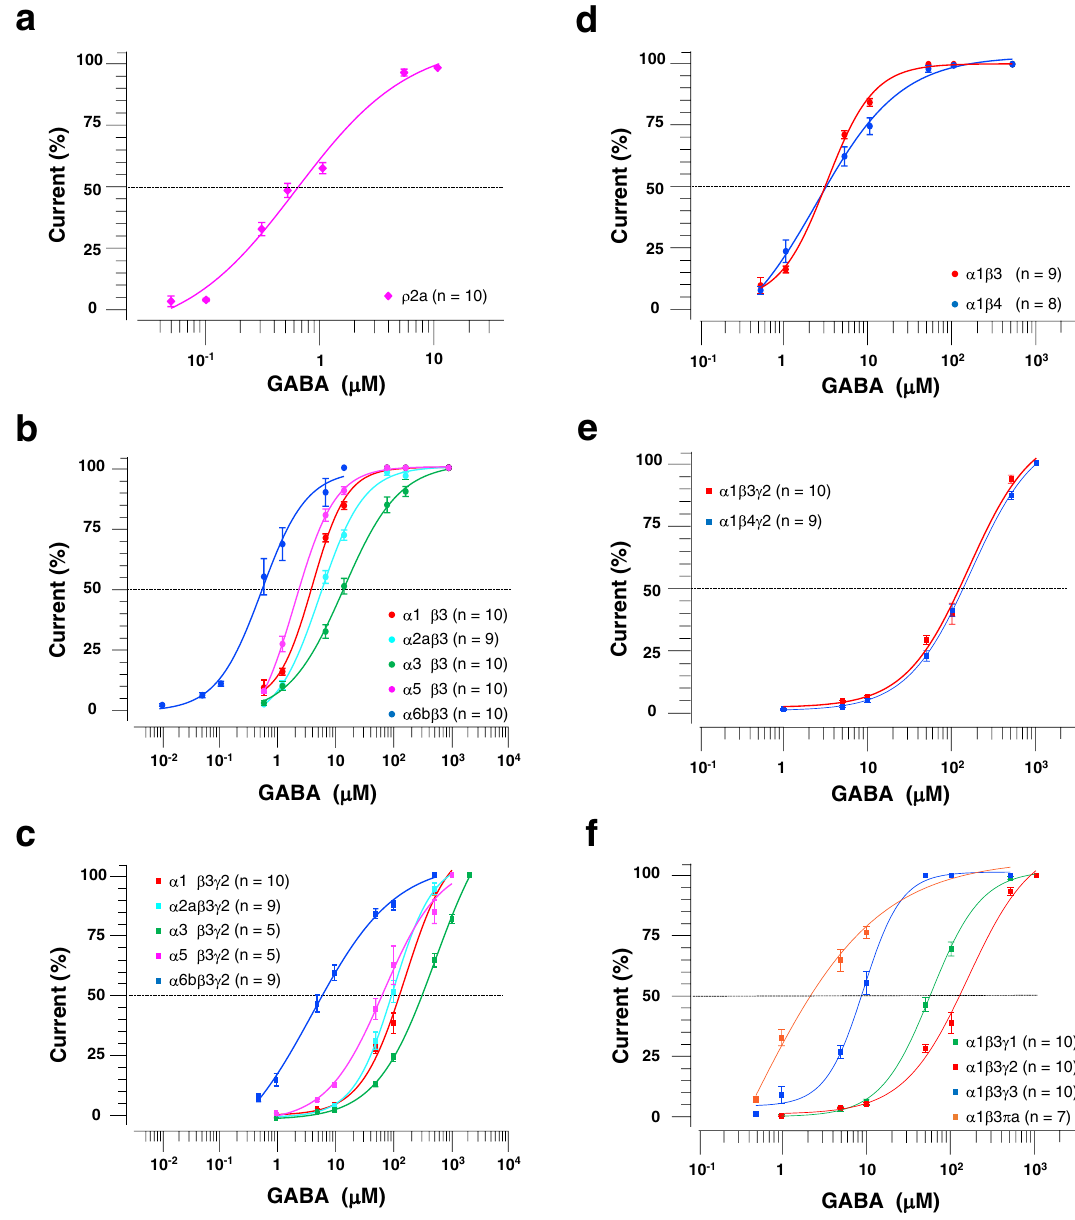
Figure 3. Electrophysiological sensitivities of zebrafish GABA A receptors to GABA. ( a ) Cumulative dose– response relationship of GABA-evoked currents recorded from Xenopus oocytes expressing the ρ2a subunit. ( b ) Cumulative dose–response relationship of GABA currents by the recombinant expression of the α subunit with the β3 subunit. ( c ) Cumulative dose–response relationship of GABA currents by the expression of the α subunit with the β3 and γ2 subunits. ( d ) Cumulative dose–response relationship of GABA currents by the expression of the β subunit with the α1 subunit. ( e ) Cumulative dose–response relationship of GABA currents by the expression of the β subunit with the α1 and γ2 subunits. ( f ) Cumulative dose–response relationship of GABA currents by the expression of γ or π subunits with α1 and β3 subunits. The amplitude of each GABA-evoked response was normalized to the maximally evoked current for each